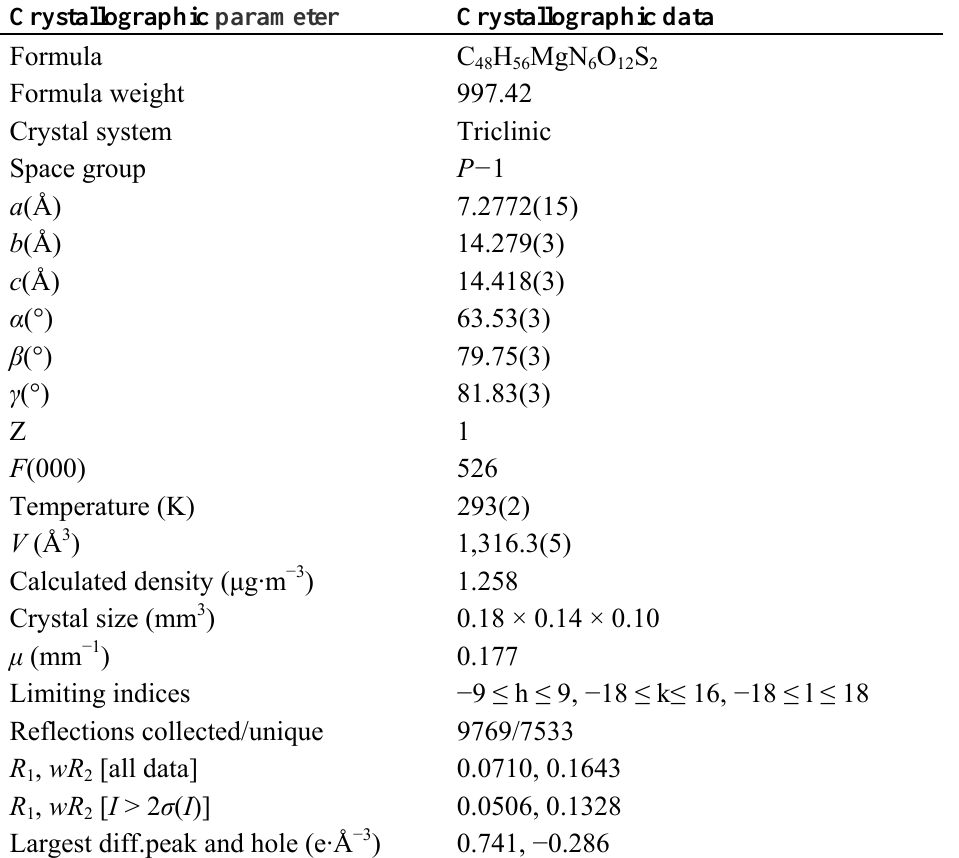
Table 1. Crystallographic data for Mg(II) complex.